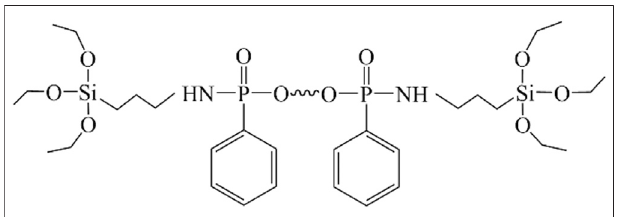
FIGURE 1 | Chemical structure of